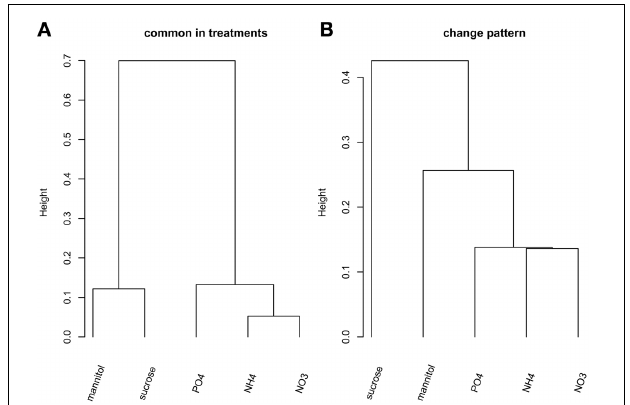
FIGURE 1 | Hierarchical clustering (“complete” linkage method) of the five nutrient/organic solute treatments. (A) Clustering based on the inverse of the ratio between actual number of common proteins and the associated expected number based on PhosPhAt. (B) Clustering of the treatments based on the change pattern